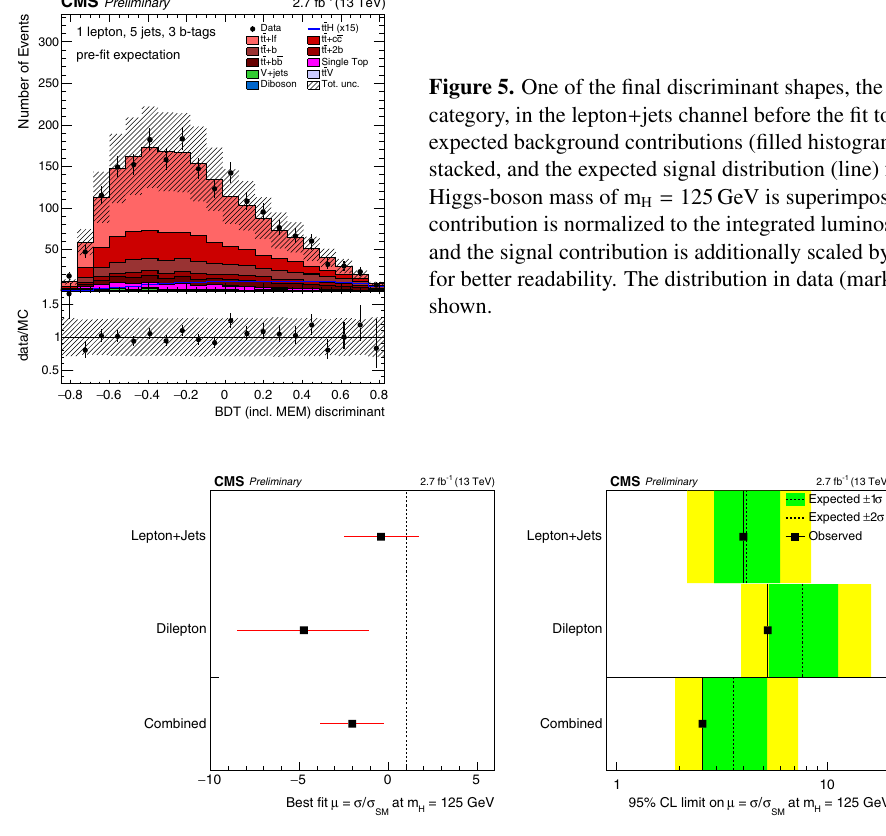
Figure 6. Best-fit values of the signal strength modifiers µ with their ± 1 σ confidence intervals (left). Median expected and observed 95% C.L. upper limits on µ (right). The expected limits are displayed together with ± 1 σ and ± 2 σ confidence intervals [3]. Table 2. Best-fit value of the signal strength modifier µ and expected and observed 95% C.L. upper limits (UL) in the lepton + jets and dilepton channels as well as the combined results [3]. The one standard deviation ( ± 1 σ ) confidence intervals of the best-fit values and the expected limits are also